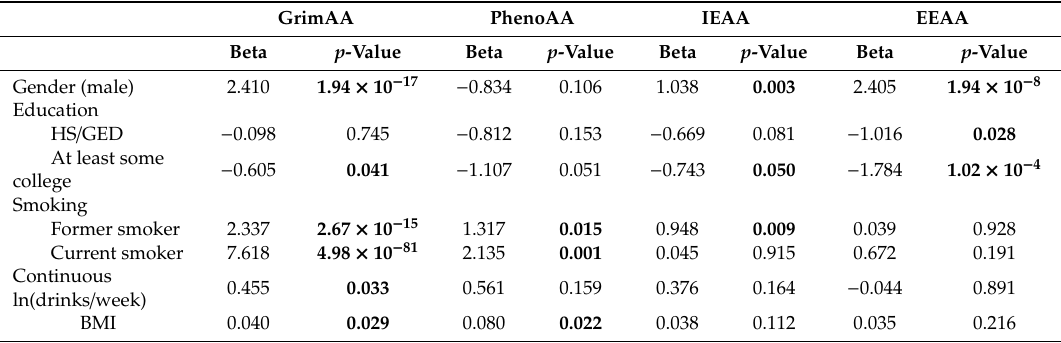
Table 2. Associations of DNAm Age acceleration with education and lifestyle factors using multivariable models (Model